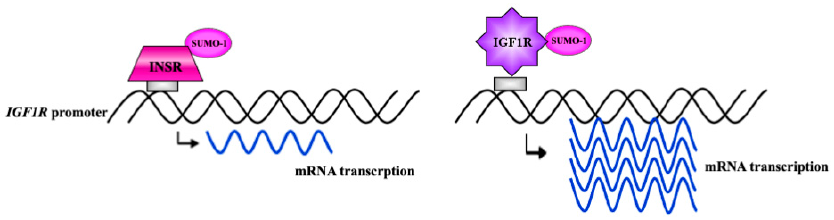
Figure 2. Comparison between the roles of InsR and IGF1R in transcriptional regulation of the IGF1R gene. InsR and IGF1R were shown to translocate to the cell nucleus and bind to the IGF1R gene promoter. However, whereas IGF1R stimulated its cognate promoter, InsR inhibited IGF1R promoter activity. The impact of the differential regulation of IGF1R gene expression by InsR and IGF1R is yet to be elucidated.